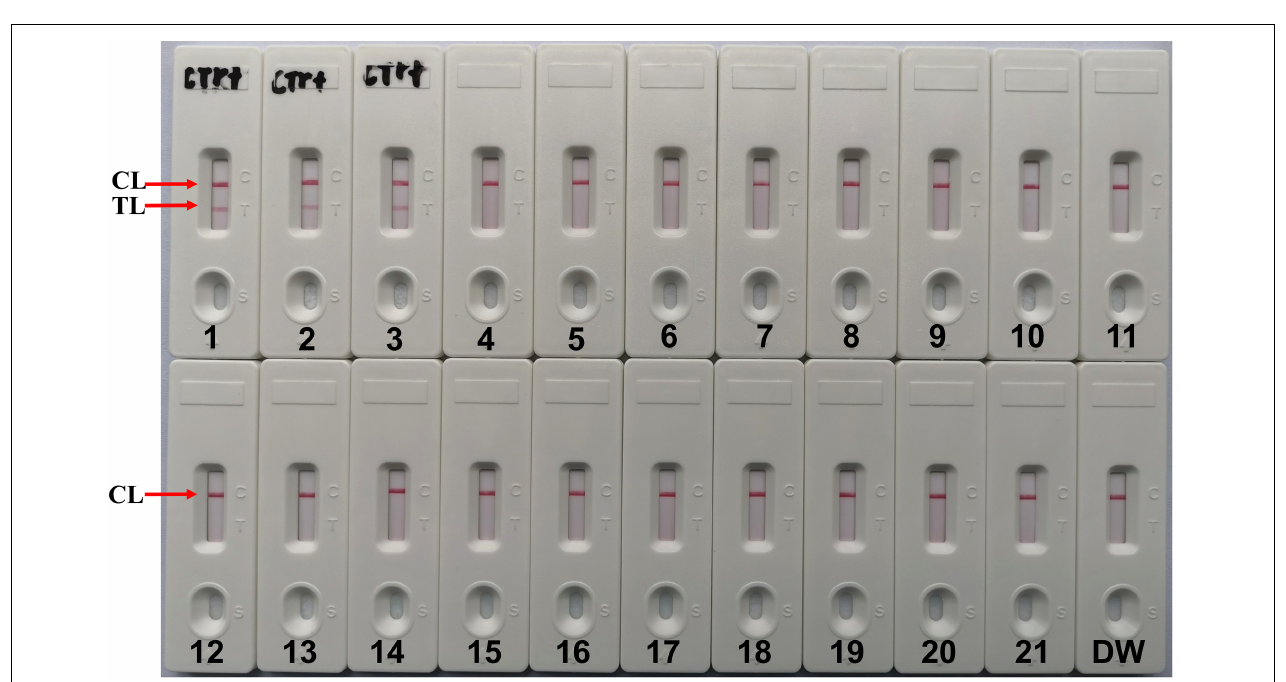
FIGURE 6 | Specificity of LFB assays detecting C. tropicalis -MCDA products. The C. tropicalis -MCDA-LFB assay was evaluated with different genomic DNA as templates. Both the control line and the test line were visible in LFB for all C. tropicalis , and only the control line was appeared in non- C. tropicalis . LFB devices were labeled C. tropicalis (Ctr) as positives after the test results were obtained. 1, Positive control ( C. tropicalis ATCC13803), 2–3, isolated C. tropicalis strains; 4–6, Candida albicans ; 7, Candida dubliniensis ; 8, Candida stellatoidea ; 9, Candida guilliermondi ; 10, Candida krusei ; 11–12, Candida parapsilosis ; 13, Candida glabrata ; 14, Cryptococcus neoformans ; 15, Penicillium mameffei ; 16, Aspergillus flavus ; 17, Staphylococcus aureus ; 18, Enterococcus faecium ; 19, Klebsiella pneumoniae ; 20, Pseudomonas aeruginosa ; 21, Acinetobacter baumannii ; 22, a blank control (DW).